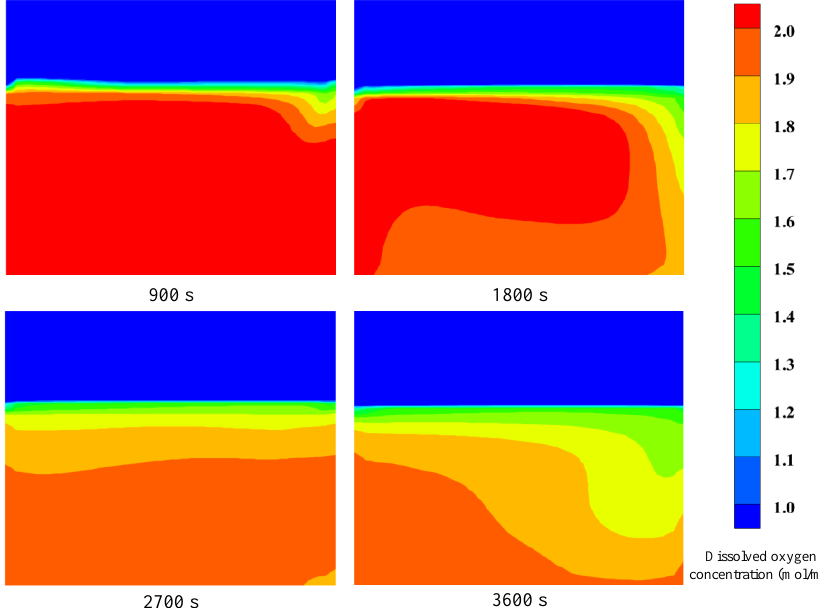
Figure 5. Variation in dissolved oxygen concentration versus flight time.